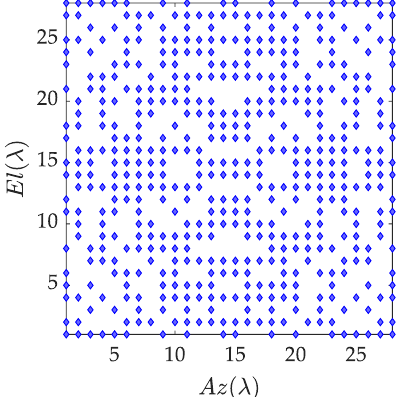
Figure 7. Distribution of array elements after optimization.